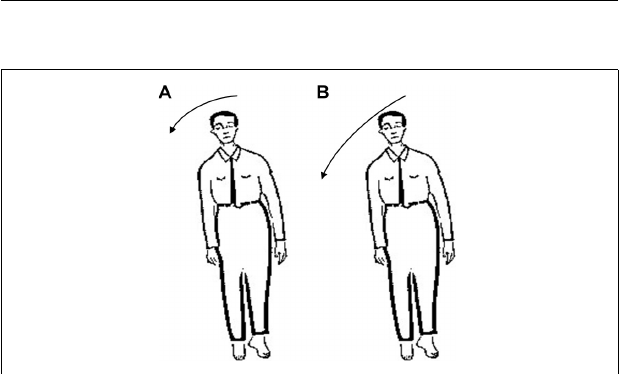
FIGURE 2 | Comparison of different performance of patients with cerebellar ataxia in Romberg’s test. (A) Eye opening stage and (B) eye closure stage.